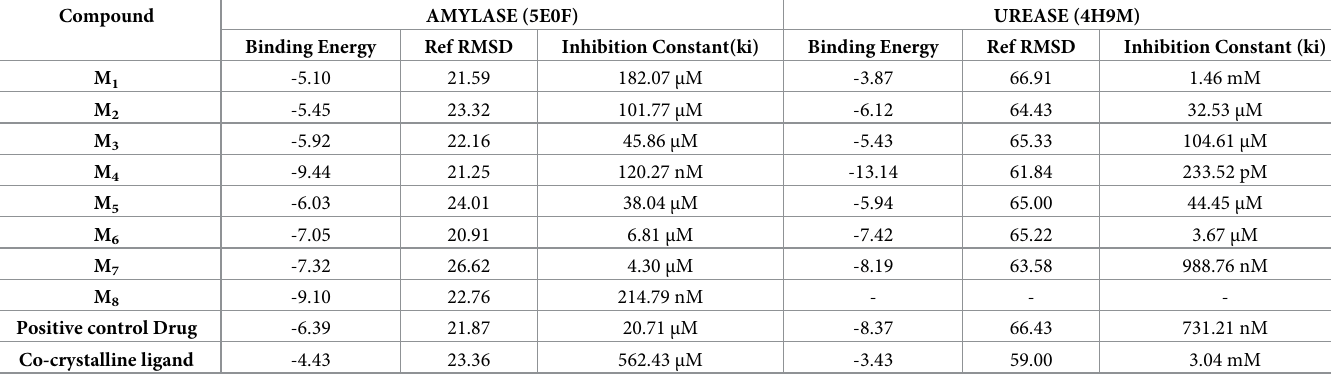
Table 4. The results of In-silico molecular docking of the parent molecule and its structural analogues. Compound